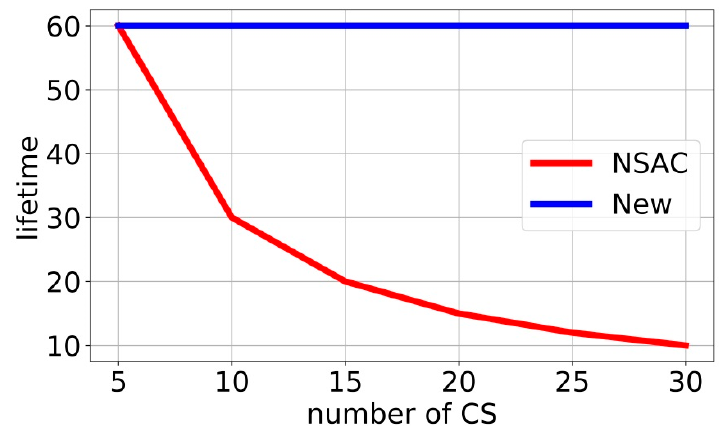
Figure 8. The performance comparison of the proposed method and network stability-aware clustering (NSAC).